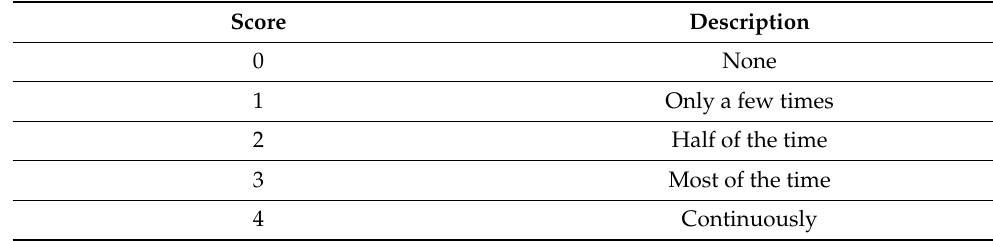
Table 4. Numerical rating scale for the owner’s assessment of the extent of signs of distress, anxiety, and/or fear. Modified from Lamminen et al. (2021)